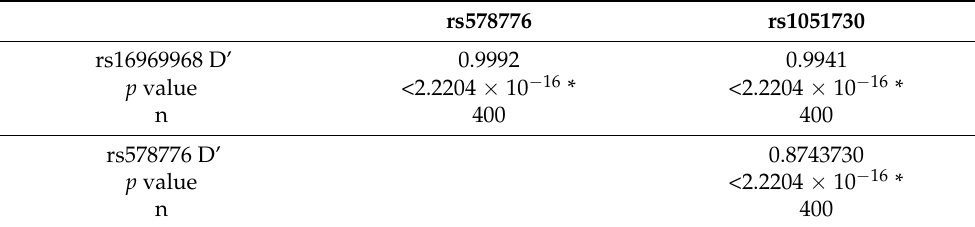
Table 3. Linkage disequilibrium between polymorphisms rs16969968, rs578776, and rs1051730 rs1051730 in the group of nicotine-dependent (ND) subjects and